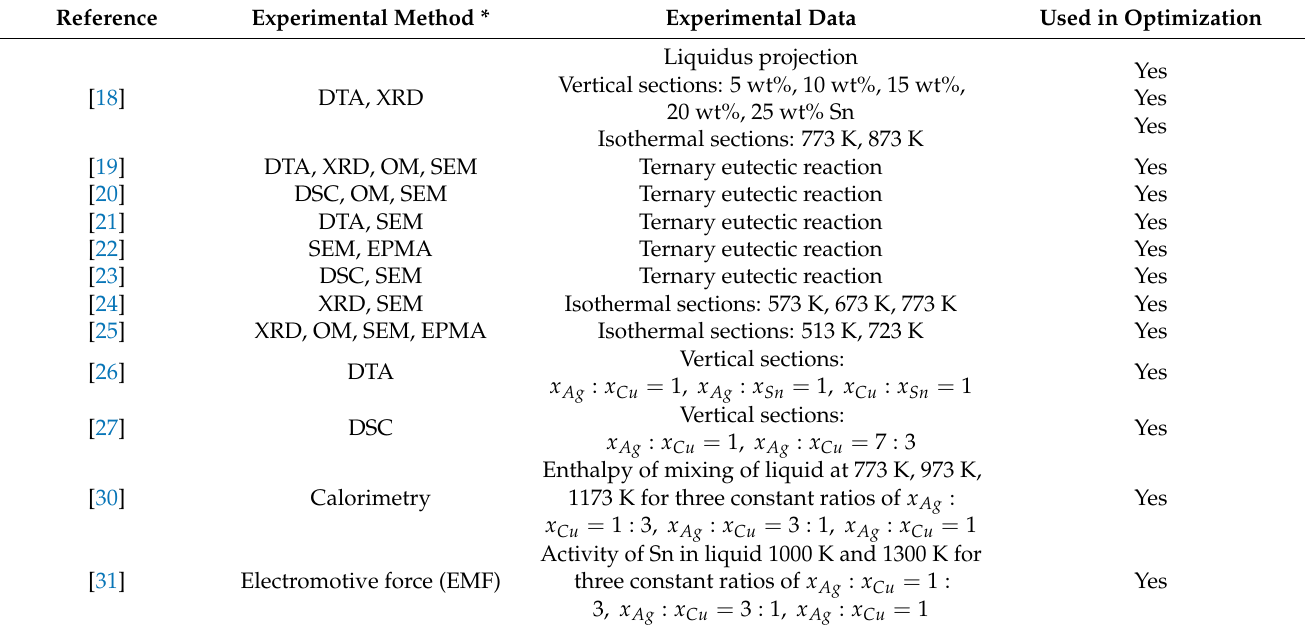
Table 1. Experimental information in the Ag-Cu-Sn ternary